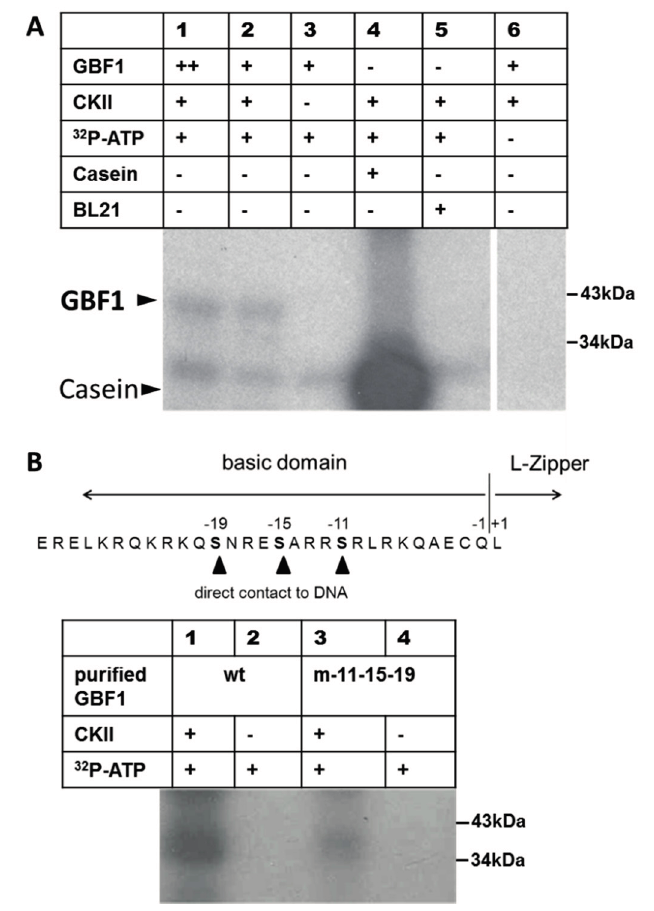
Figure 1. In vitro kinase assay with mammalian CKII. ( A ) E. coli BL21 raw lysate expressing recombinant GBF1 or no recombinant protein (BL21, lane 5) incubated with or without mammalian Casein Kinase II (NEB). Calf casein (Qiagen) was used as control substrate. Size in kDa is indicated on the right. ++: 45 μ g, +: 15 μ g raw protein lysate. All probes contained unlabeled ATP (100 μ mol); ( B ) Purified 6×His-tagged GBF1 protein (wt) or mutated at position − 11/ − 15/ − 19 of the basic domain (m − 11 − 15 − 19) incubated with or without mammalian CKII